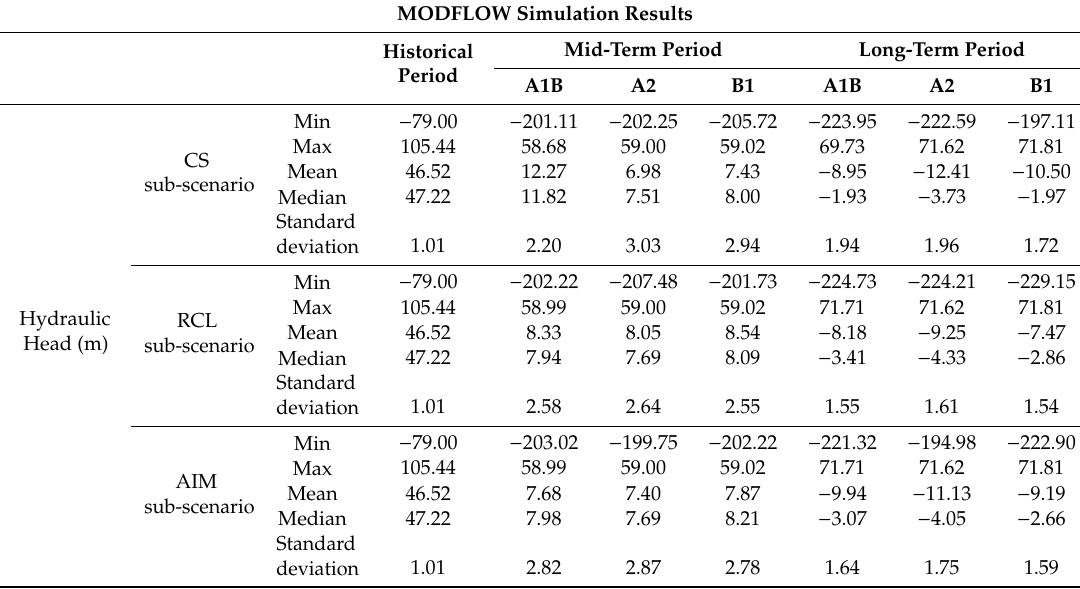
Table 4. Simulation results from MODFLOW for water demand sub-scenarios of reservoir operation